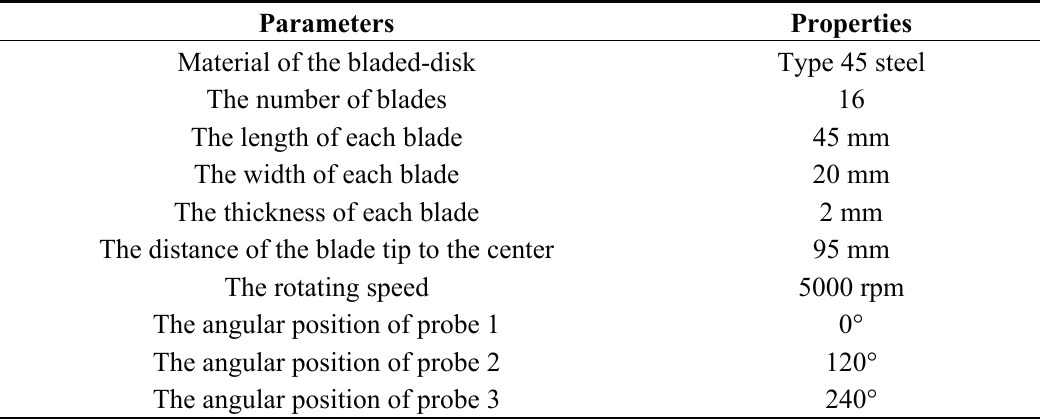
Figure 5. The frequency spectrum of the original signal. Table 1 . Experimental